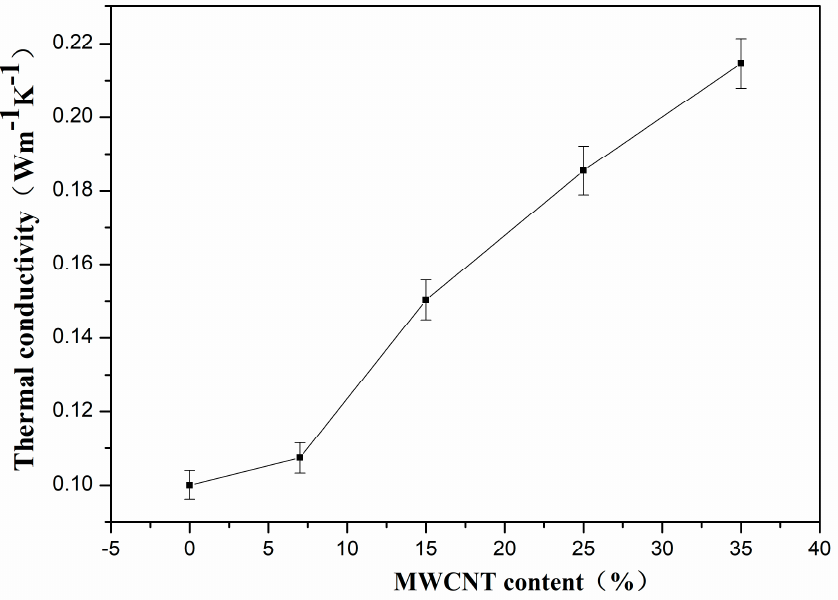
Figure 3. The thermal conductivity of PVDF/MWNTs composites with different content of MWNTs at room temperature.